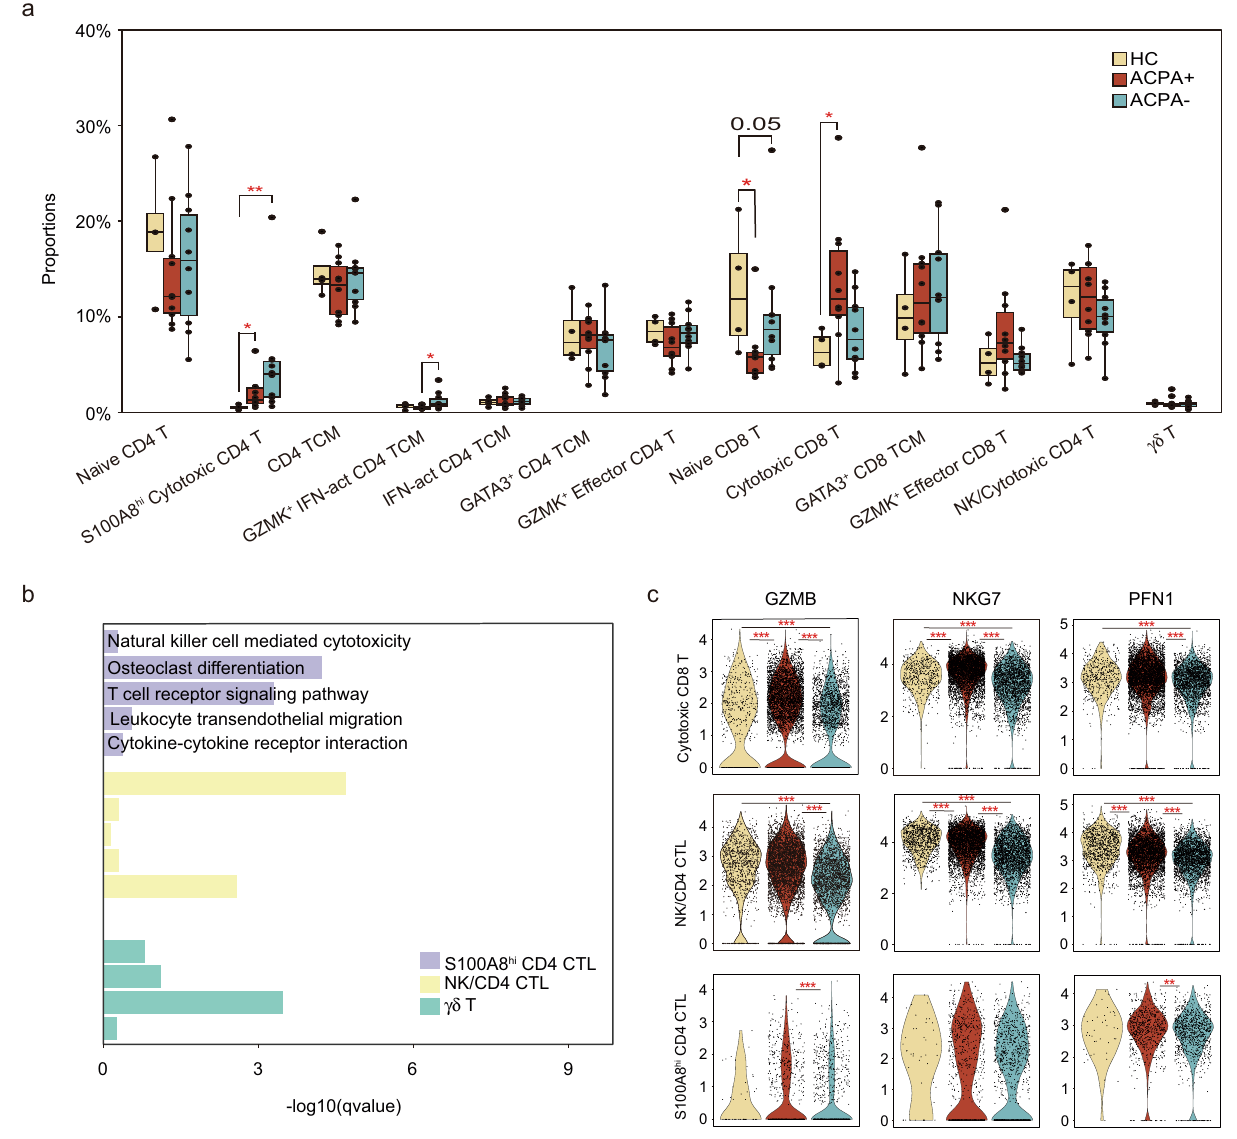
Fig. 8 Expression pattern of T and NK cell subsets in the blood of patients with RA. a Box plots showing the proportions of each T/NK cell subtype in PBMC across ACPA groups. Cell types showed enrichment in ACPA + or ACPA- subgroups are marked with *. P values were calculated by the two-sided Wilcoxon test. * p < 0.05 (from left to right, p = 0,014, 0.011, 0.024, and 0.036), ** p < 0.01 ( p = 0.004). n = 4 for HC, n = 10 for ACPA + group, and n = 10 for ACPA- group. b Bar plots showing the enriched upregulated KEGG pathways and GO biological processes in terms of speci fi c T/NK cell subtypes. c Violin plots showing the differences in interested gene expression between ACPA- and ACPA + T/NK cell subtypes in PBMC. Asterisks indicate the signi fi cance. P values were calculated by the two-sided Wilcoxon test. * p < 0.05, ** p < 0.01, *** p <